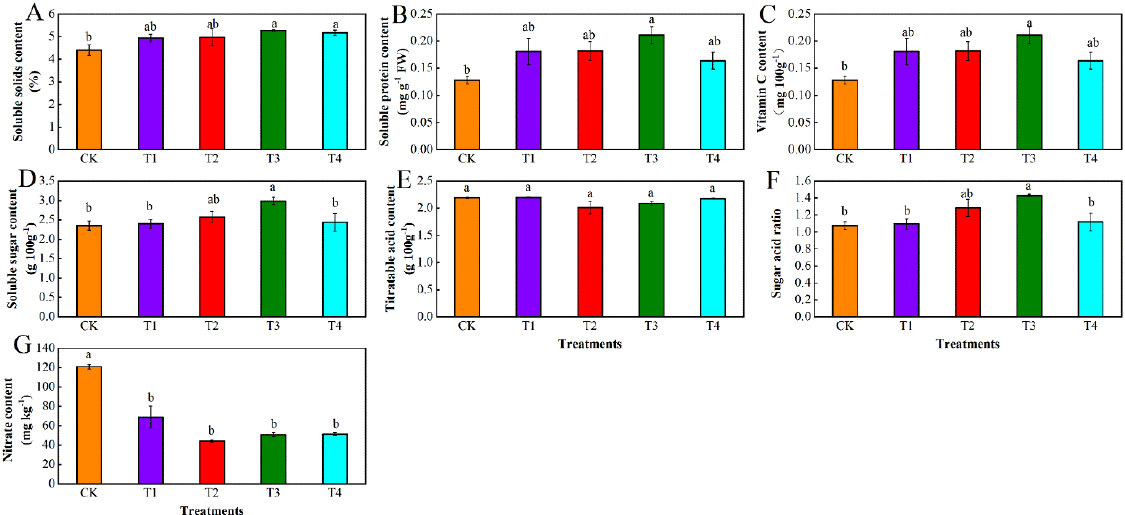
Figure 4. Effect of different levels of water deficit on the content of soluble solids ( A ), soluble protein ( B ), vitamin C ( C ), soluble sugar ( D ), titratable acid ( E ), sugar-to-acid ratio ( F ), and nitrate ( G ) in tomato fruit. The abbreviations CK, T1, T2, T3, and T4 are defined in the footnote of Table 1. The data are presented as mean ± SE of three biological replicates. Different lowercase letters indicate